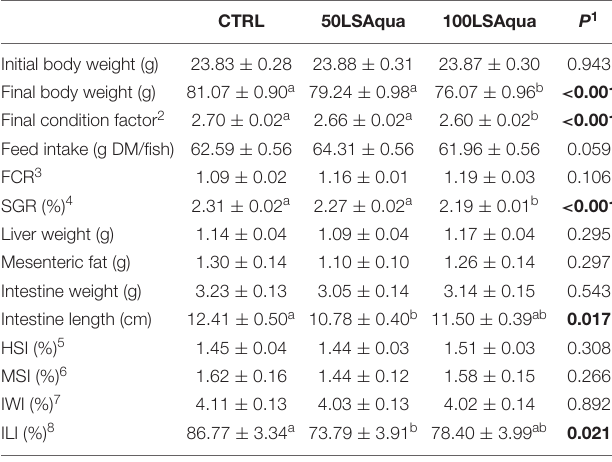
TABLE 2 | Effects of dietary treatment on growth performance of gilthead sea bream juveniles fed to visual satiety from May to July (8 weeks) with CTRL, 50LSAqua and 100LSAqua